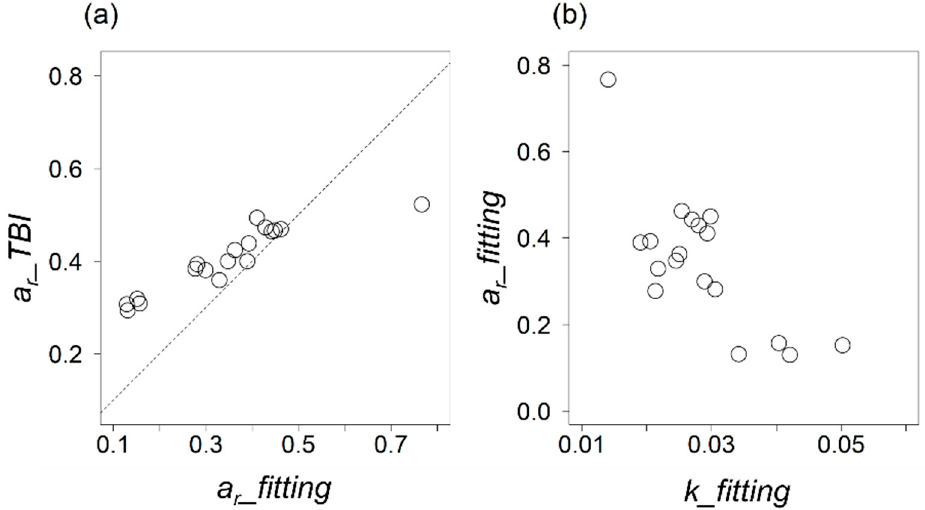
Figure 5. Relationships between ( a ) a r _TBI and a r _fitting and ( b ) a r _fitting and k_fitting . Dashed line indicates the 1:1 line.